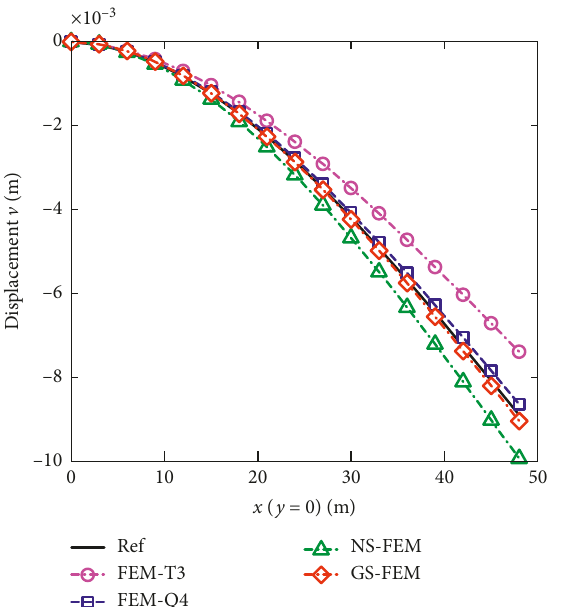
Figure 5: Displacement v along y � 0. Figure 6: Displacement relative error v − v